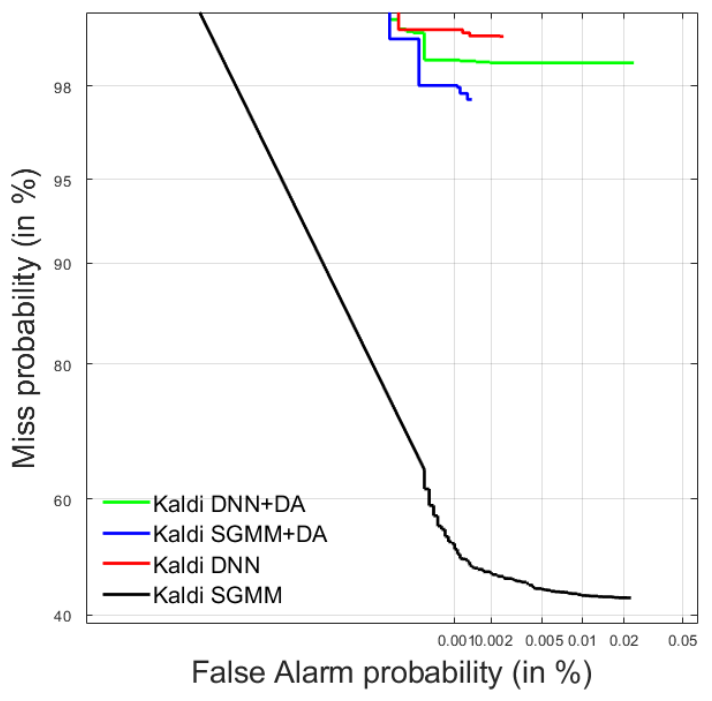
Figure 7. DET curves of the STD systems for SPARL20 test